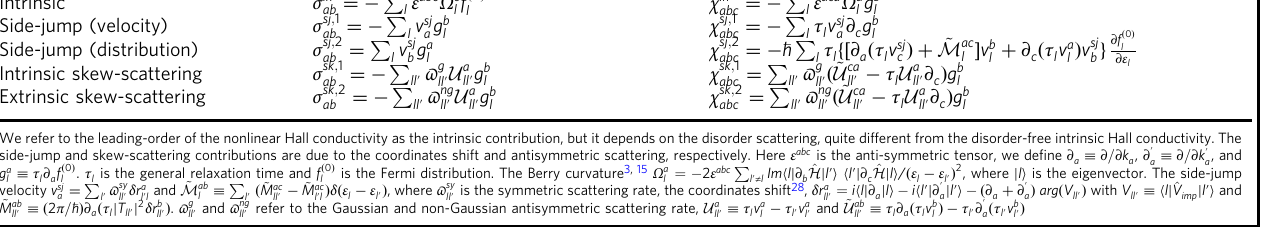
contributions vanish as ε F ! 1 . These behaviors can be seen in Fig. 2e. The zero-frequency nonlinear Hall response was not addressed experimentally. In the ωτ (cid:4) 1 limit, ξ yxx ¼ χ yxx . According to symmetry, ξ xyy ¼ 0. In the dc limit ( ω ¼ 0), the electric fi eld